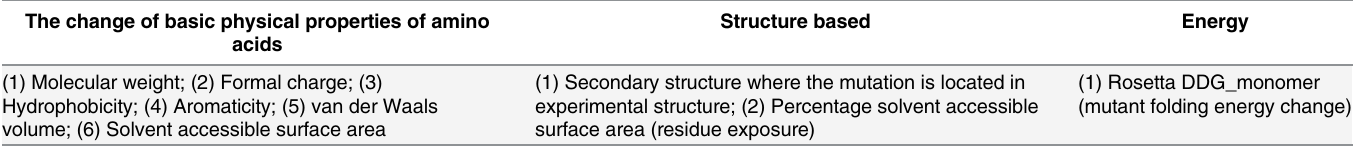
Table 2. The descriptor set used for modeling. The change of basic physical properties of amino